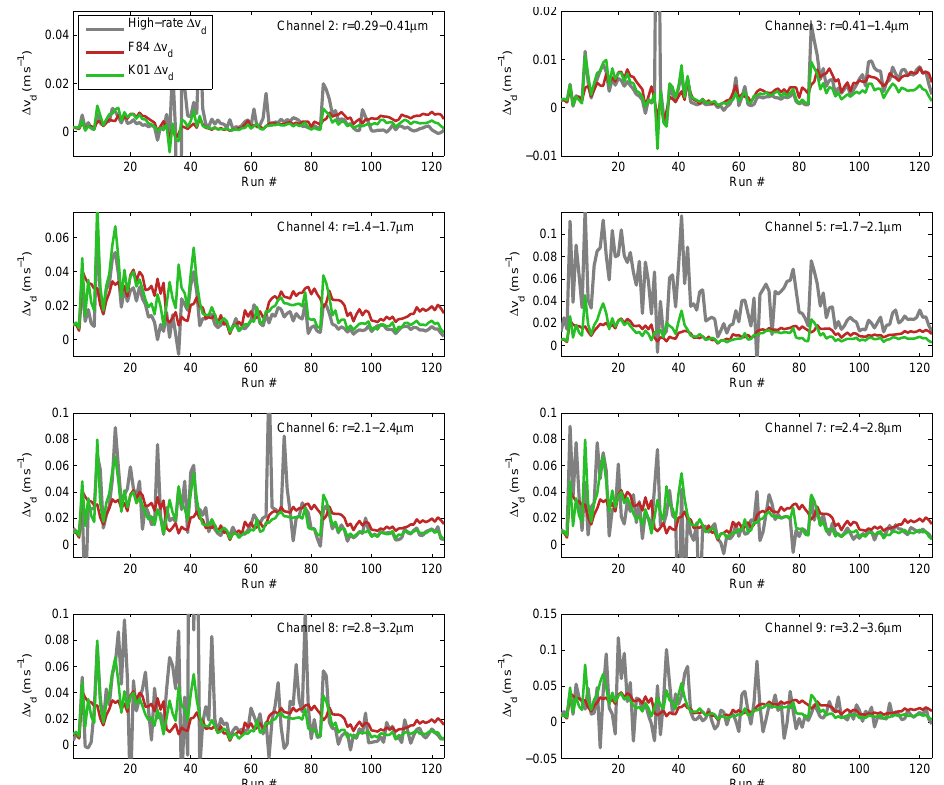
Fig. 9. Apparent deposition velocity due to hygroscopicity, 1v d , calculated through K01’s and F84’s methods, modified to use a piecewise (log-)linear Junge form, and the difference in high-rate deposition velocity between raw and RH-corrected (to run mean) spectra. CLASP channels 2–9 are